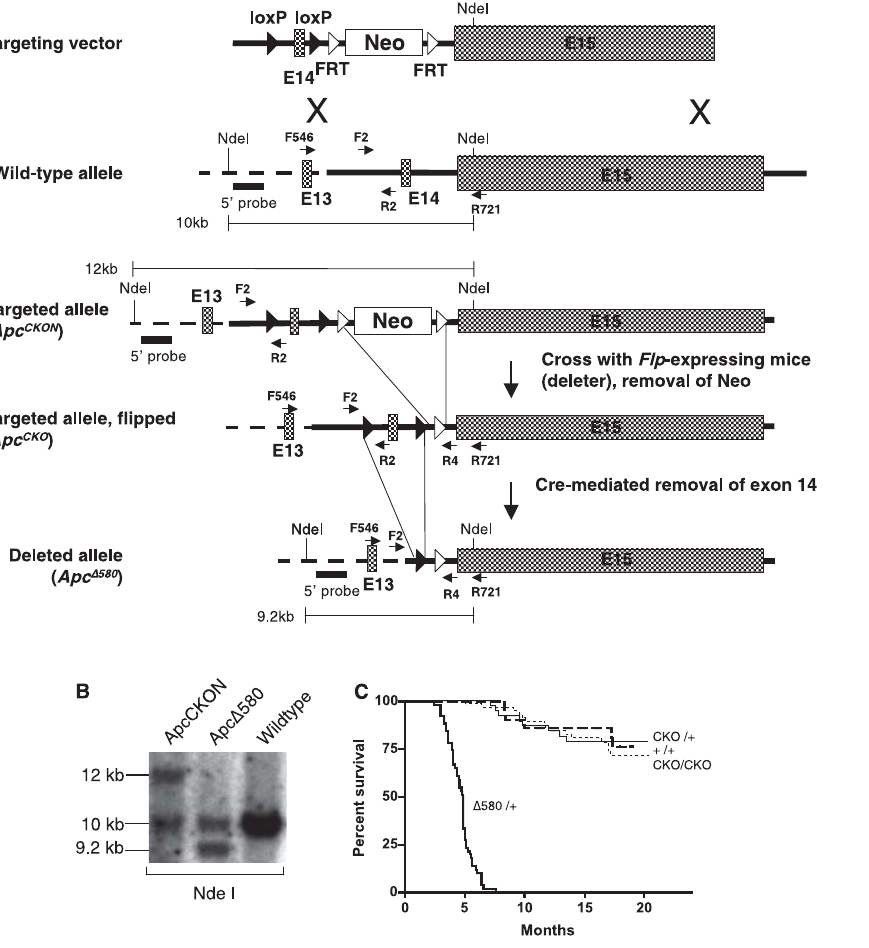
Figure 1. Generation of the Conditional Apc Allele (A) Schematic diagram of exons 14 and 15 of the mouse Apc gene, the targeting vector, and the resulting conditional allele with 2 LoxP sites sandwiching the exon 14. The PGK-neomycin cassette was inserted within intron 14 by recombineering technique. This cassette is sandwiched by 2 FRT sites that could be removed by crossing to FLPe-expressing mice. Positions of PCR primers used for genotyping PCR (F2, R2, R4) and RT-PCR (F546 and R721) are indicated. Positions of probe used for Southern blot analysis with NdeI sites are also shown. Upon Cre-mediated recombination, exon 14 is removed and leads to truncated Apc protein, of which the first 580 aa correspond to the normal. (B) Southern blot analysis of NdeI-digested genomic tail DNA isolated from F1 mice of various Apc mouse lines (Apc CKON , Apc D 580 ), hybridized to a 600- bp probe. Tail genomic DNA from Apc CKON F1 mice derived from a modified ES clone showed a 12-kb band for the Apc CKON allele and a 10-kb band for the wild-type allele, whereas genomic DNA from the Apc D 580 mouse was heterozygous for the Apc D 580 allele (9.2-kb band). (C) Kaplan-Meier survival plot of Apc CKO/ þ mice (thin solid line, n ¼ 39), Apc CKO/CKO mice (thin dotted line, n ¼ 57), Apc D 580/ þ mice (solid line, n ¼ 51), and wild-type littermates (broken line, n ¼ 21). Heterozygosity of the Apc D 580 allele led to a significantly shortened survival ( p , 0.0001), whereas those of heterozygous and homozygous Apc CKO mice had no significant difference to that of wild-type littermates. DOI: 10.1371/journal.pgen.0020146.g001 as the single layered ectodermal stage of embryonic day (E) 9.5 [19]. A restricted expression of K14 is also found in thymic epithelial cells (TECs) in the medulla of normal thymus [20]. We genotyped a total of 458 pups (8–10 d old) from 67 litters resulting from crosses between K14-cre; Apc CKO/ þ and Apc CKO/CKO mice. The mutant mice of the genotype K14-cre; Apc CKO/CKO (hereafter, KA mutant) were born, but the observed frequency of KA mutants was much less than expected (78 of 458 [17.0%]; p , 0.0005 Chi-square analysis, Table 1). To assess the basis for the neonatal lethality of KA mutants, we monitored three litters from birth to weaning by measuring the body weight of each pup every day. A total of 25 pups were born from three litters, of which 7 (28%) were confirmed to be K14-cre; Apc CKO/CKO by genotyping, indicating that KA mutants were born in the expected Mendelian ratio. PLoS Genetics |